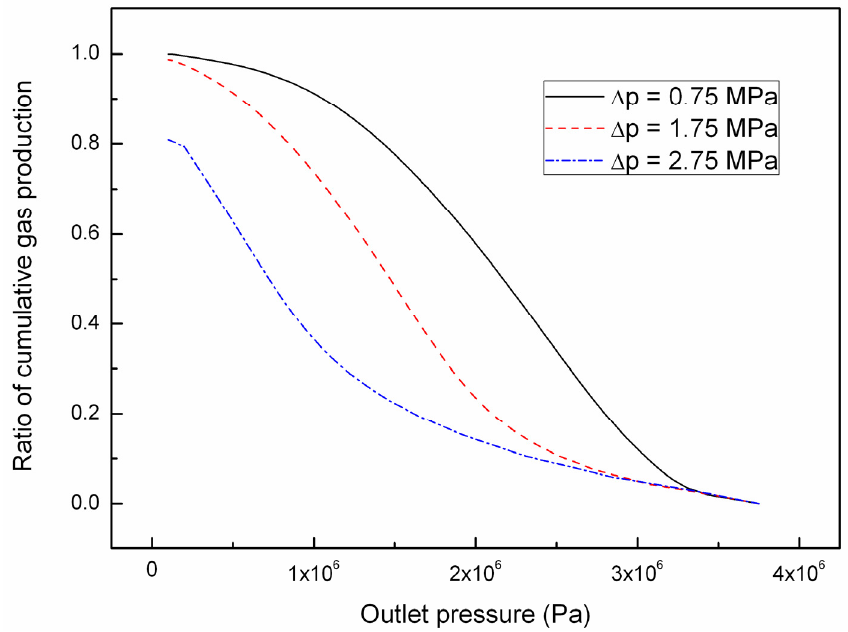
Figure 10. The relationships between the percentage of cumulative gas production and outlet pressure for the Class 1 of combined depressurization